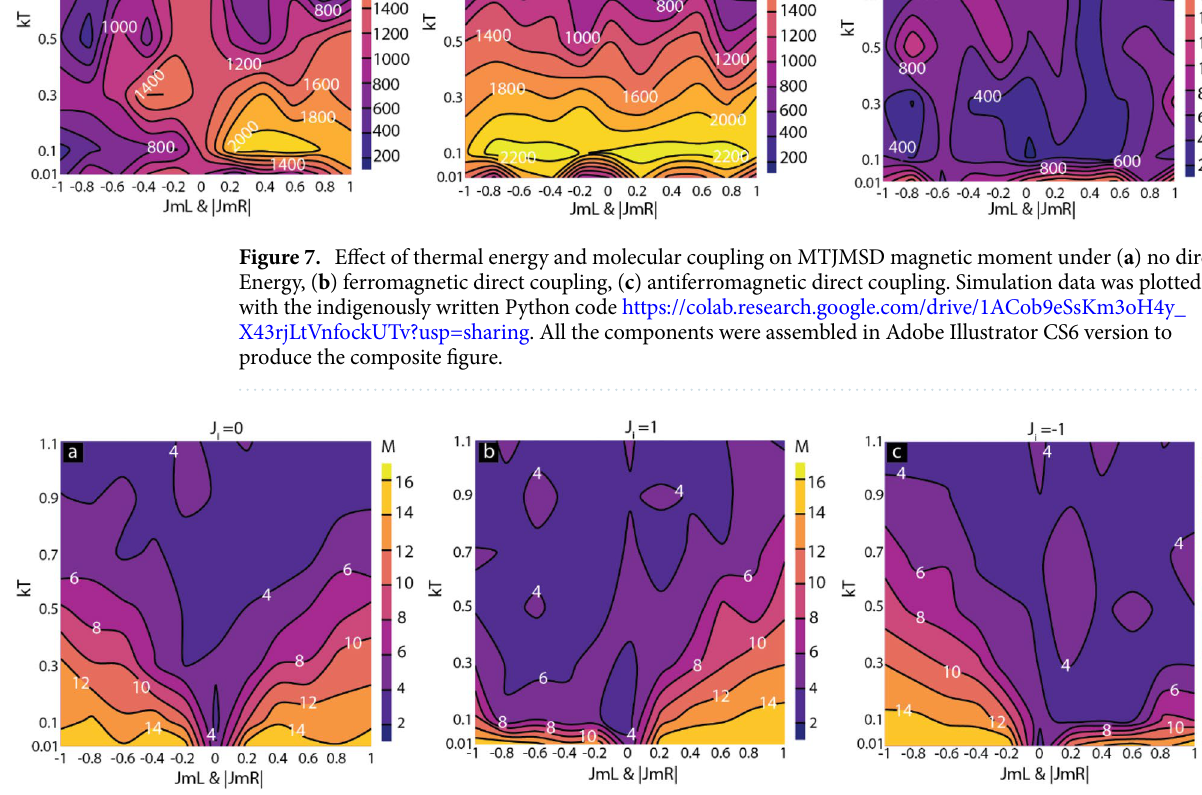
Figure 8. Effect of thermal energy and molecular coupling on molecular magnetic moment under ( a ) no direct Energy, ( b ) ferromagnetic direct coupling, ( c ) antiferromagnetic direct coupling. Simulation data was plotted with the indigenously written Python code https:// colab. resea rch. google. com/ drive/ 1ACob 9eSsK m3oH4y_ X43rj LtVnf ockUTv? usp= shari ng. All the components were assembled in Adobe Illustrator CS6 version to produce the composite